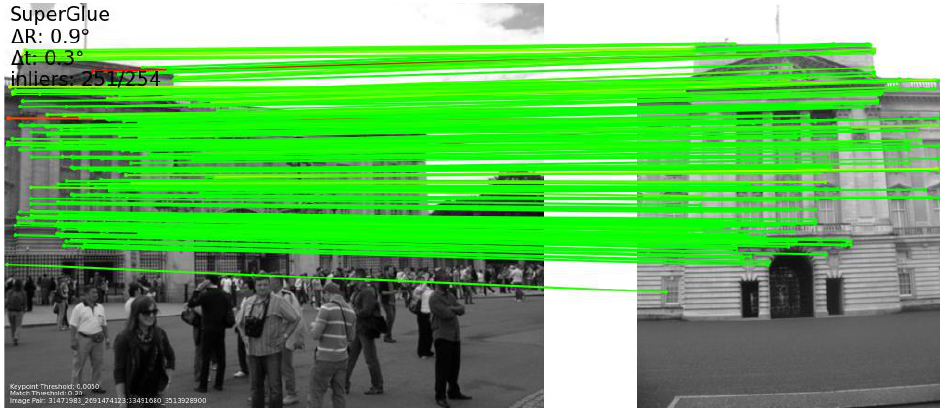
Figure 11. Simulation results of feature points extraction and matching.